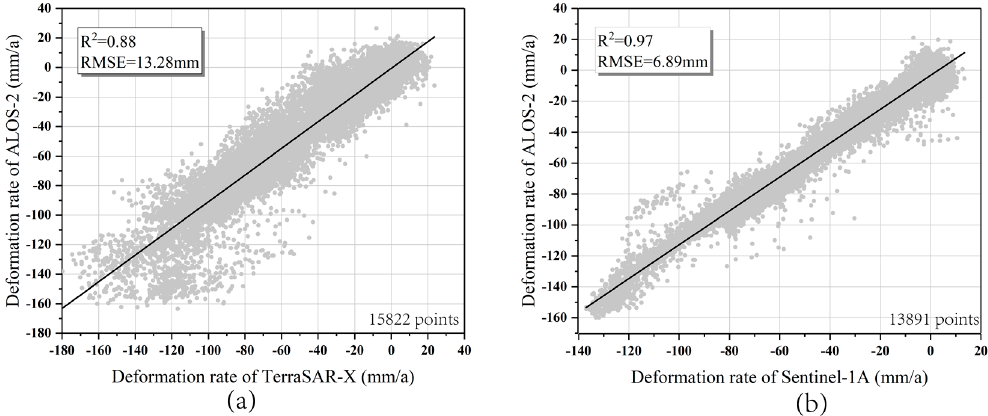
Figure 4 . Scatter plots of the vertical deformation rates among three SAR datasets. ( a ) Between ALOS- 2 and TerraSAR-X datasets, ( b ) between Sentinel-1A and ALOS-2